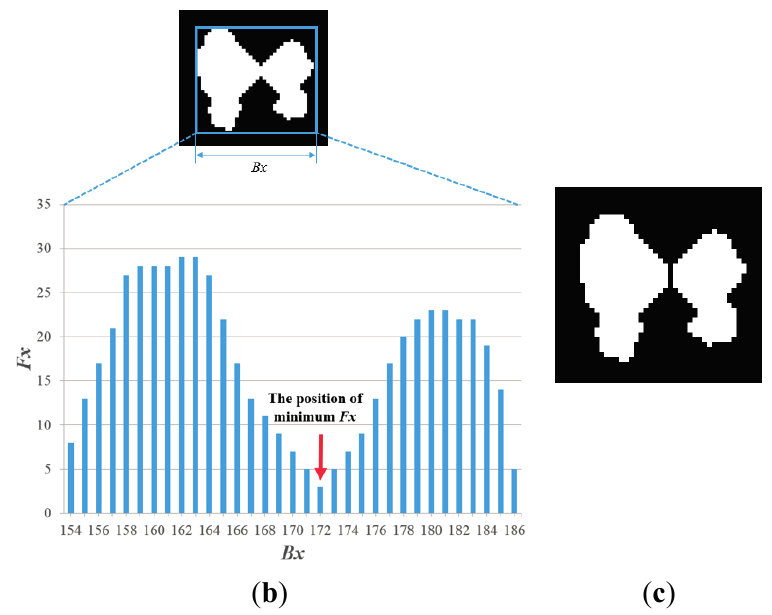
Figure 7. Division of the candidate region within an input image based on the horizontal histogram: ( a ) input image; ( b ) detected candidate region and its horizontal histogram; and ( c ) the division result of the candidate